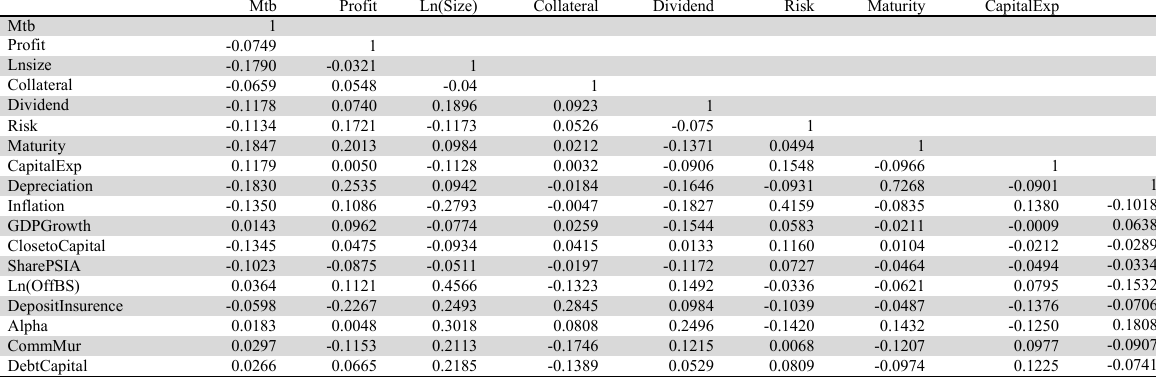
Pairwise correlation between selected independent variables (2008-2017)